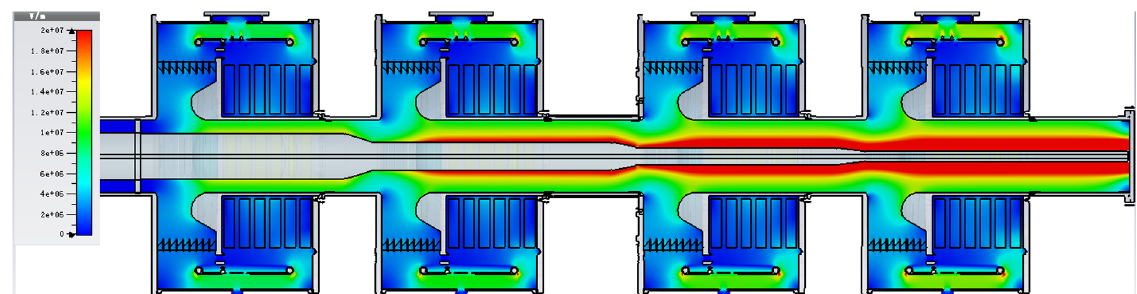
FIG. 6. Electric field distribution through the central plane of the four-stage IVA at the peak voltage